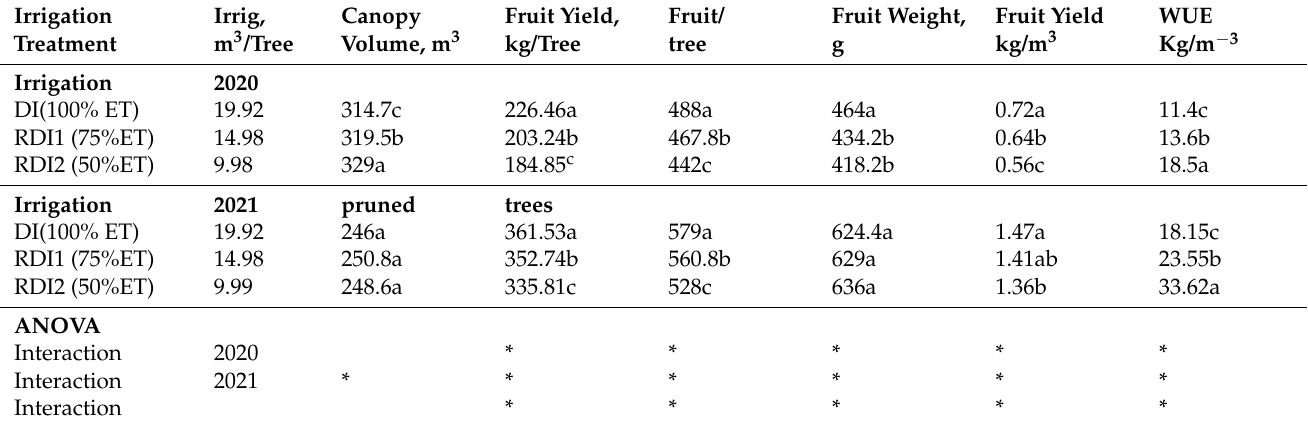
Table 7. Mature tree average fruit yield, fruit per tree, fruit weight, water applied, canopy volume and WUE for each irrigation